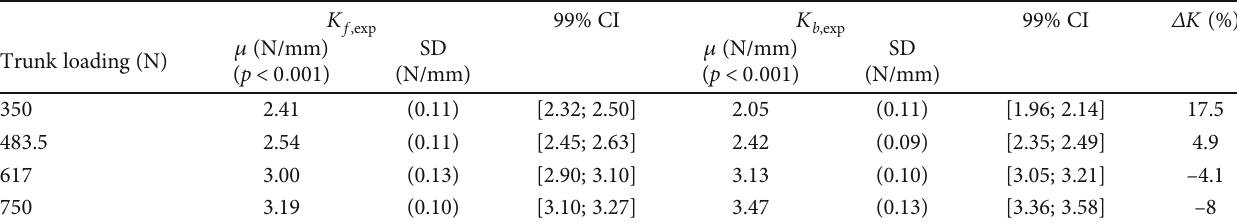
Table 1: Experimental sti ff ness results.